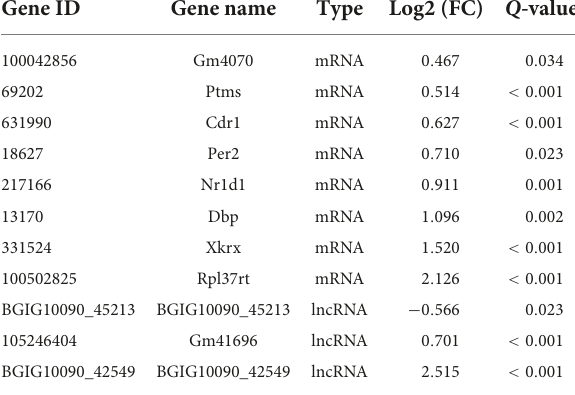
TABLE 7 Differentially expressed mRNA and lncRNA induced by paclitaxel